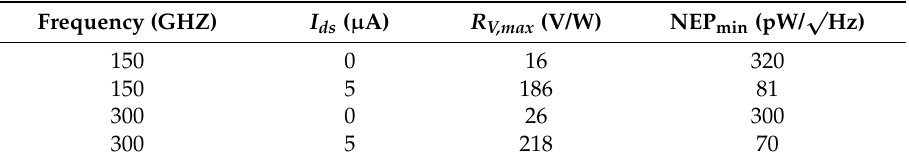
Table 1. Figures of merit of the strained MODFETs as THz detectors.